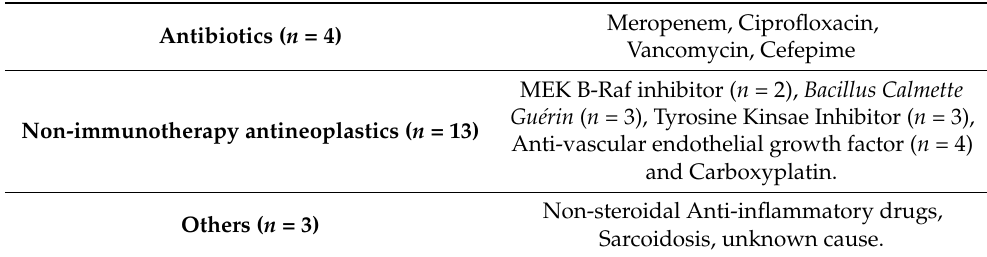
Table 5. Causes of acute interstitial nephritis not secondary to